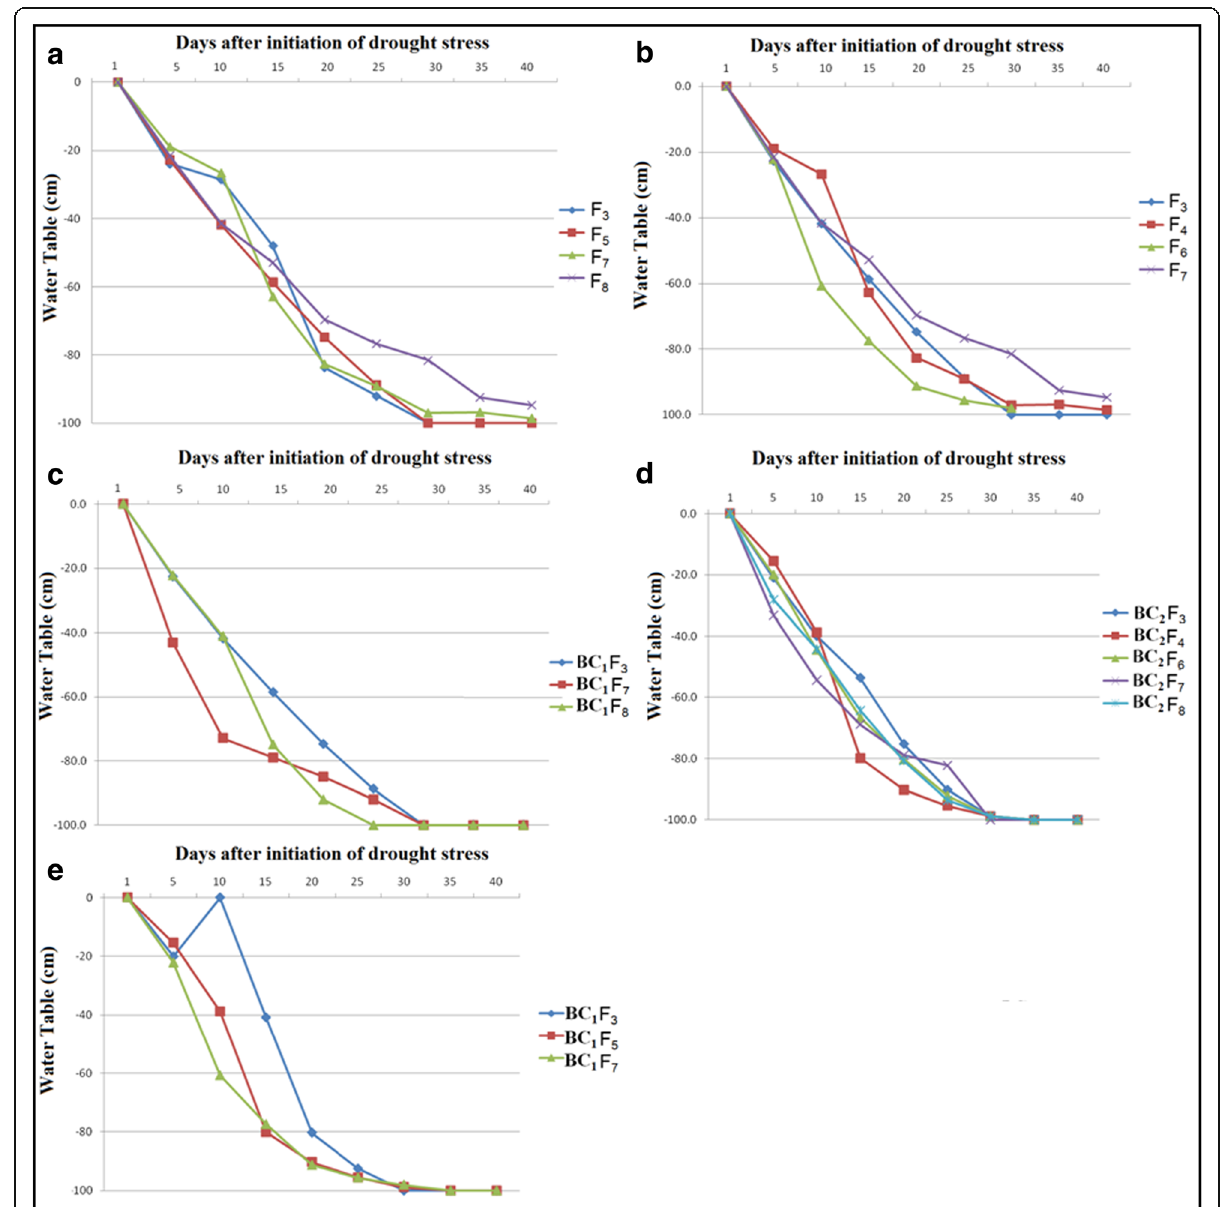
Fig. 2 Soil water potential measured by parching water table level in experiments ( a ) Swarna-Sub1 pyramided lines with qDTY 1.1 , qDTY 2.1 , and qDTY 3.1 in different generations; b IR64-Sub1 pyramided lines with qDTY 1.1 , qDTY 1.2 , qDTY 2.2 , qDTY 2.3 , qDTY 3.2 , and qDTY 12.1 in different generations; c Samba Mahsuri pyramided lines with qDTY 2.2 and qDTY 4.1 in different generations; d TDK1-Sub1 pyramided lines with qDTY 3.1, qDTY 6.1, and qDTY 6.2 in different generations; and ( e ) MR219 pyramided lines with qDTY 2.2 , qDTY 3.1, and qDTY 12.1 in different generations using polyvinyl chloride (PVC)